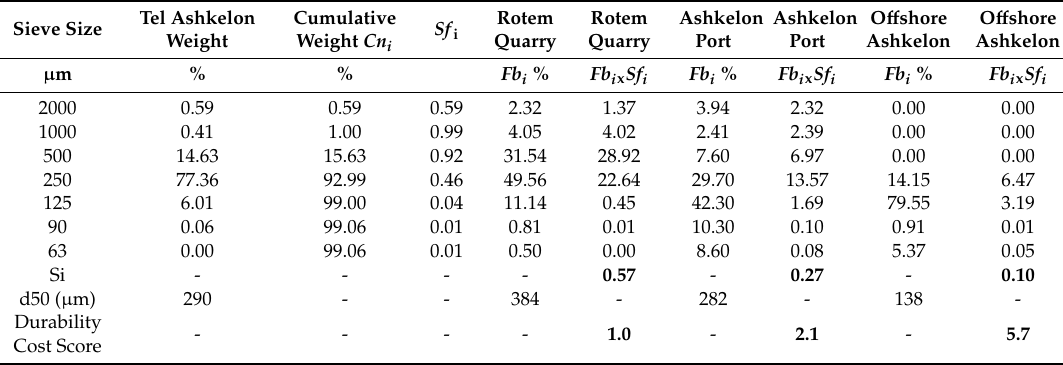
Table 1. Stability index calculation of the three alternative sand